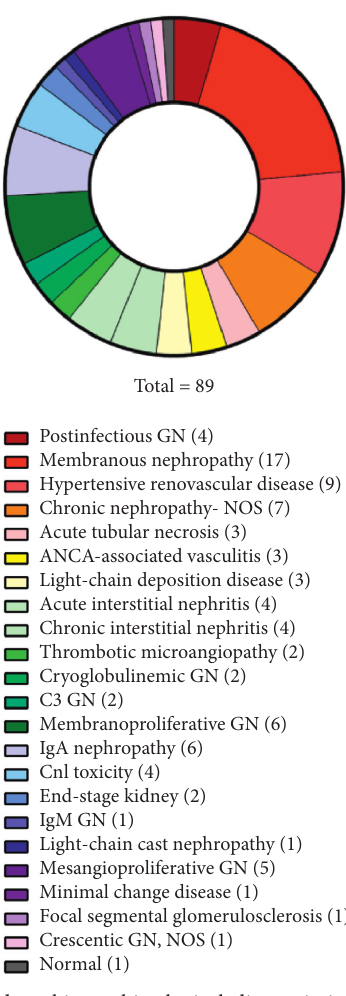
Figure 2: Kidney biopsy histological diagnosis in patients with NDKD or mixed NDKD +DKD. NOS: not otherwise specified; GN: glomerulonephritis.